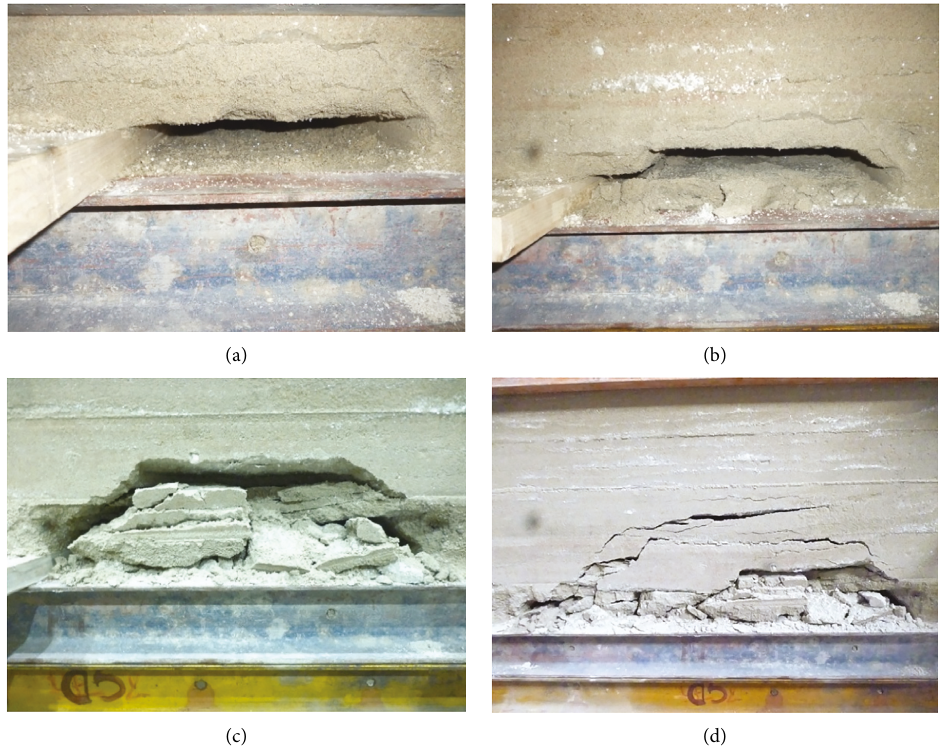
Figure 5: External failure form of overlying rock in forward knife handle working face. (a) Mining 30m. (b) Mining 60 m. (c) Mining 90m. (d) Mining